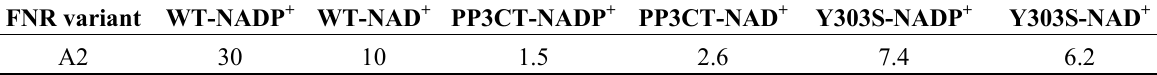
Table 1. Absolute fractional values of STD ( η proton A2, taken at saturation time of 2s for the complexes between FNR, PP3CT and FNR: Y303S with NADP + and NAD + .